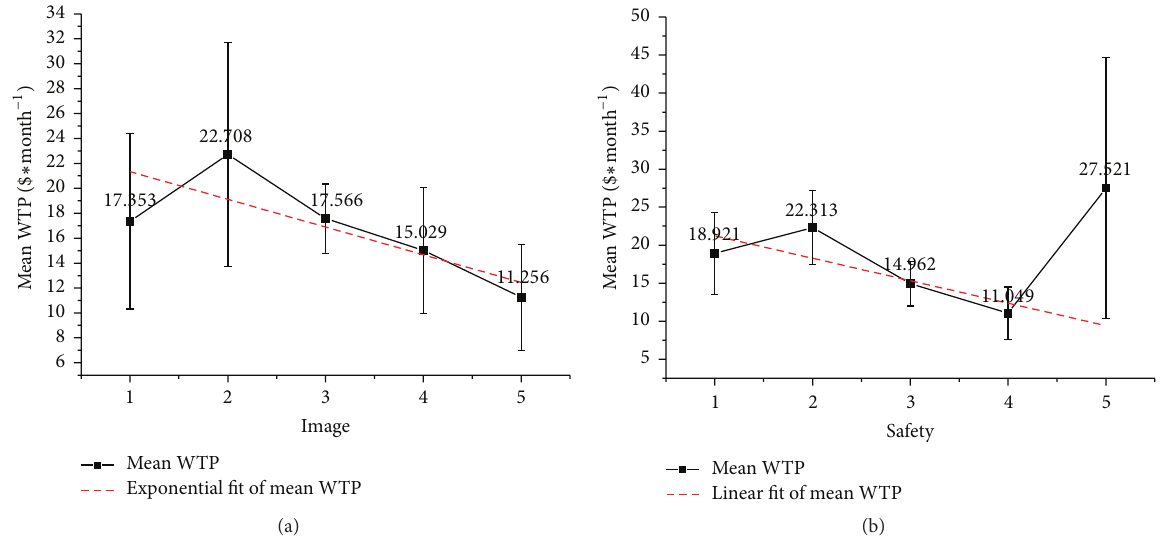
Figure 4: (a) Mean WTP of each image level and its trend line with coefficient of determination ( 𝑅 2 ) according to increasing image level. (b) Mean WTP of each safety level and its trend line with coefficient of determination ( 𝑅 2 ) according to increasing safety